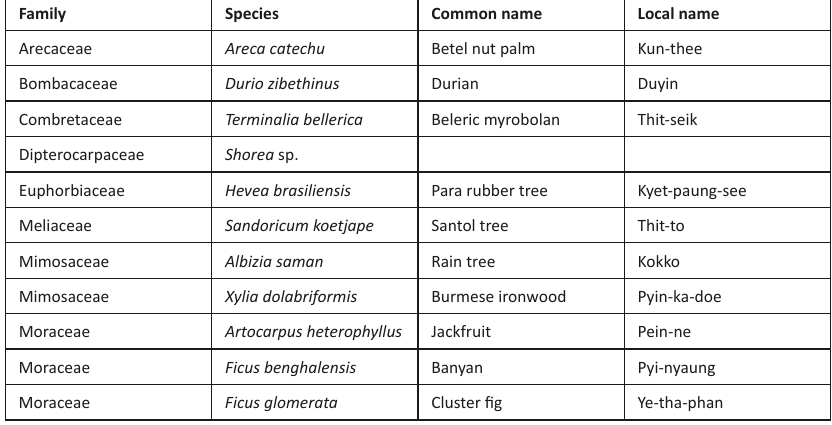
Table 2. Tree species that were observed to support Flying Fox roosts within the study area.